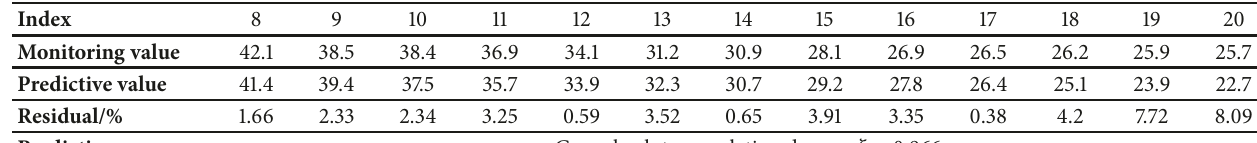
Table 8: The predictive value and the accuracy test results of skid